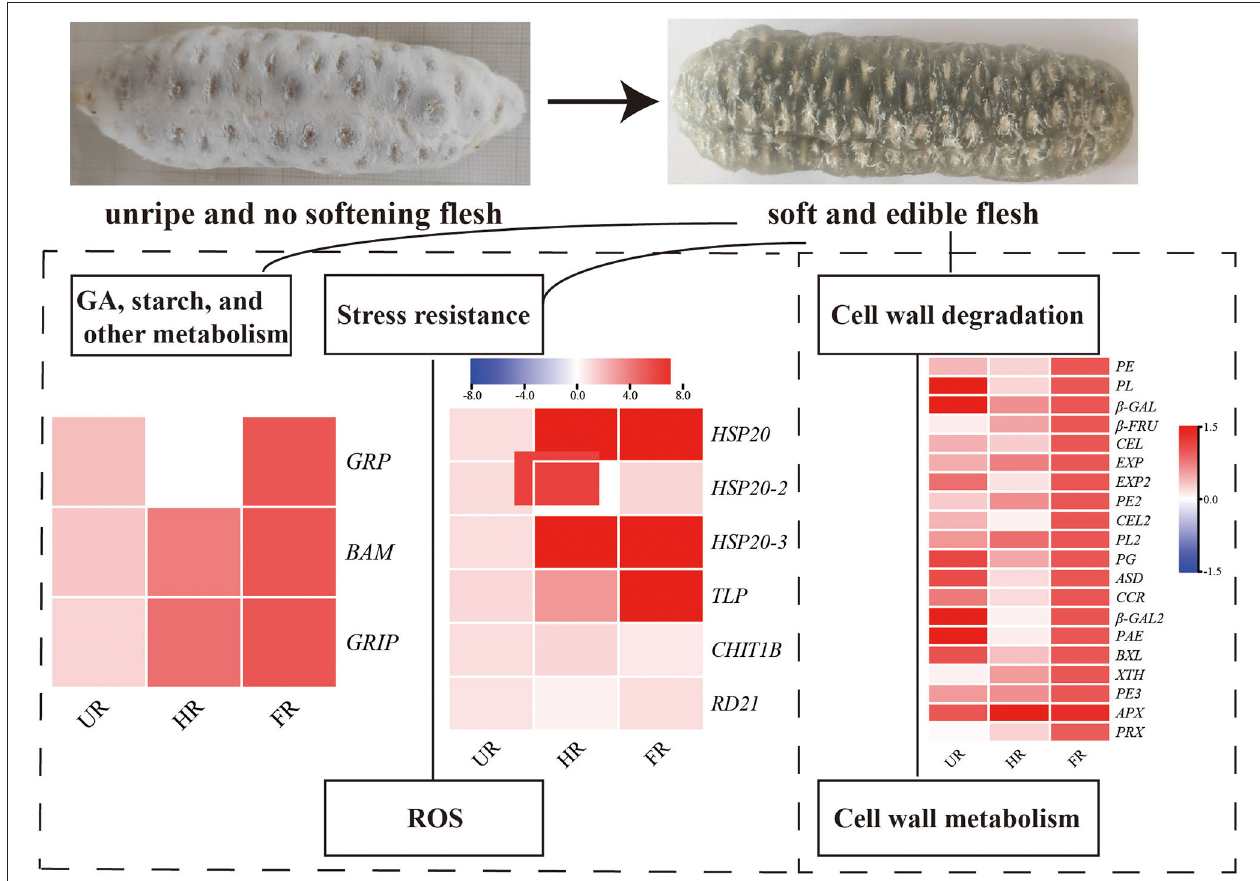
FIGURE 9 | Summary of some of the biological pathways involved in A. trifoliata fruit ripening and softening.